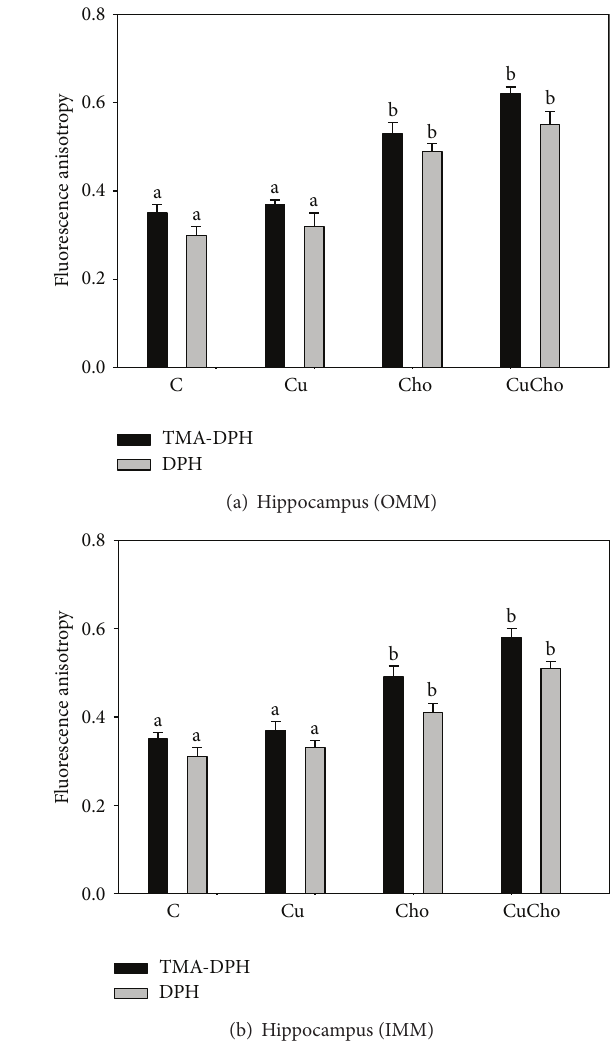
Figure7:Mitochondrialouter(a)andinner(b)membranefluidities (fluorescence anisotropy) in suspension isolated from brain cortex. Treatments are indicated with different colors, control (white bars), Cu (black bars), Cho (gray bars), and CuCho (dark gray bars). Samples were analyzed as indicated in Section 2.9. Results are expressed as the mean ± standard deviation (SD) of 10 rats. Significant differences among the experimental groups are indicated with superscript letters (values with distinct letters are significantly different between them, 𝑃 < 0.01 ).